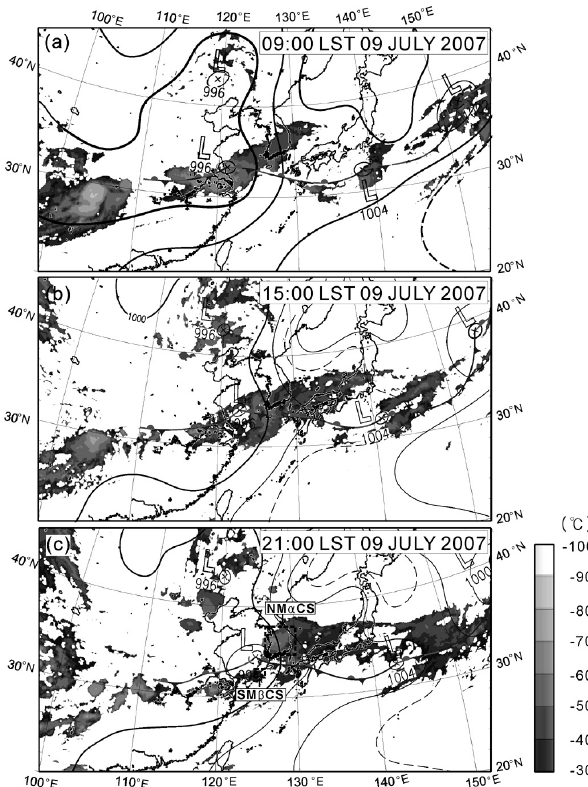
Fig. 3. Surface weather maps with superimposed MTSAT-IR images at (a) 09:00LST, (b) 15:00LST, and (c) 21:00LST, 9 July 2007. The echo areas in the northern and southern boxes of part (c) indicate NM α CS and SM β